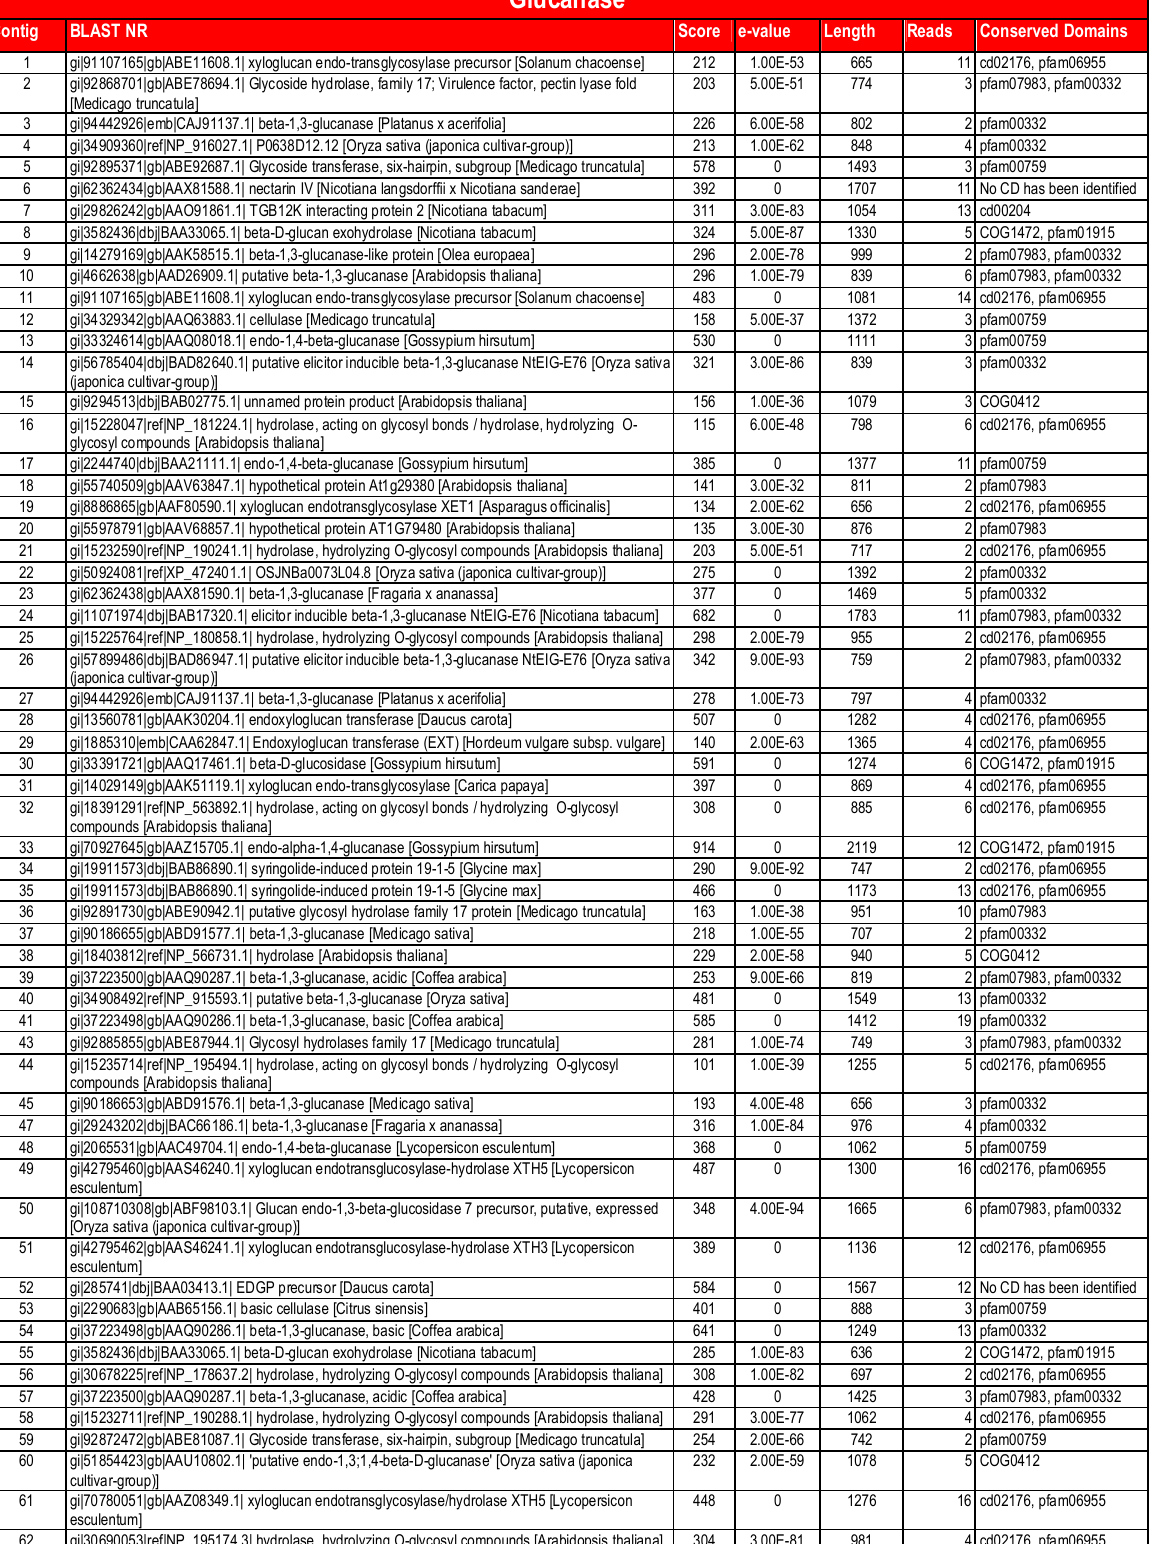
Table S7: EST-Contigs with e-value < e -20 and score > 100 obtained in the Project Glucanase, and their blast hit, score, e-value, size, number of reads, and conserved domains from putative